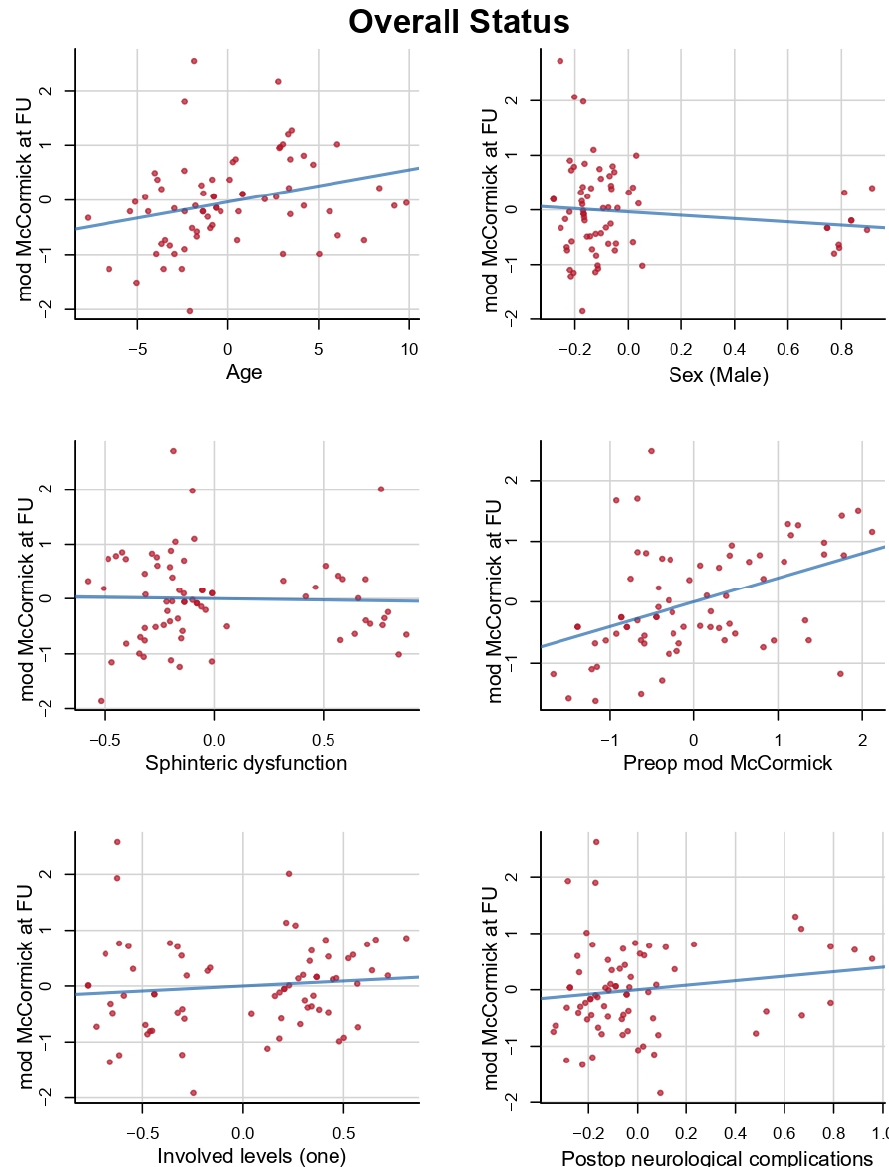
Figure 2. Variables included in the multivariate model for overall status. Multivariate analysis showed that preoperative modified McCormick was the best independent predictor of good overall status (coeff = 0.402, p = 0.00027). Patient’s age showed a statistically significant correlation with good overall status (coeff = 0.058, p = 0.02507).